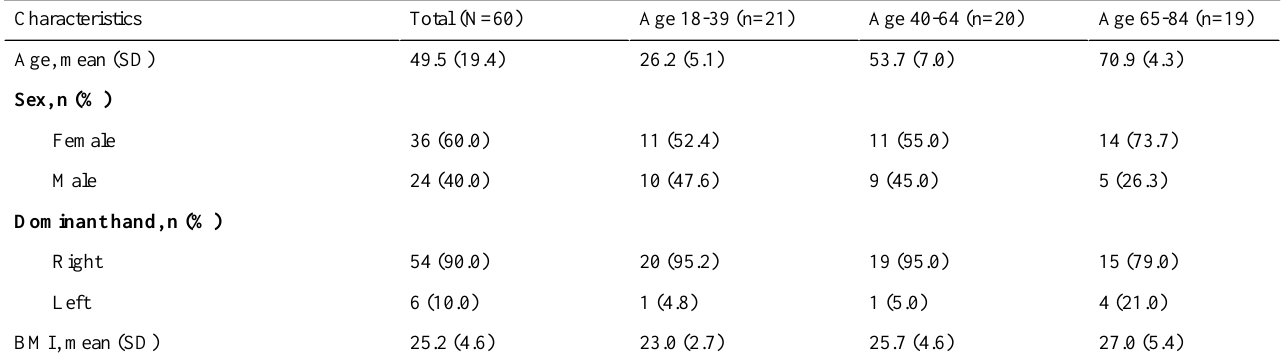
Table 1. Participant characteristics. One BMI observation was missing.